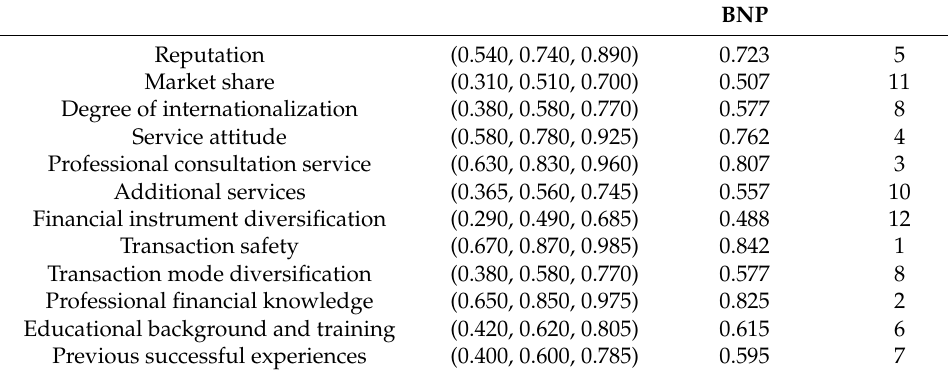
Table 3. Weights of criteria.